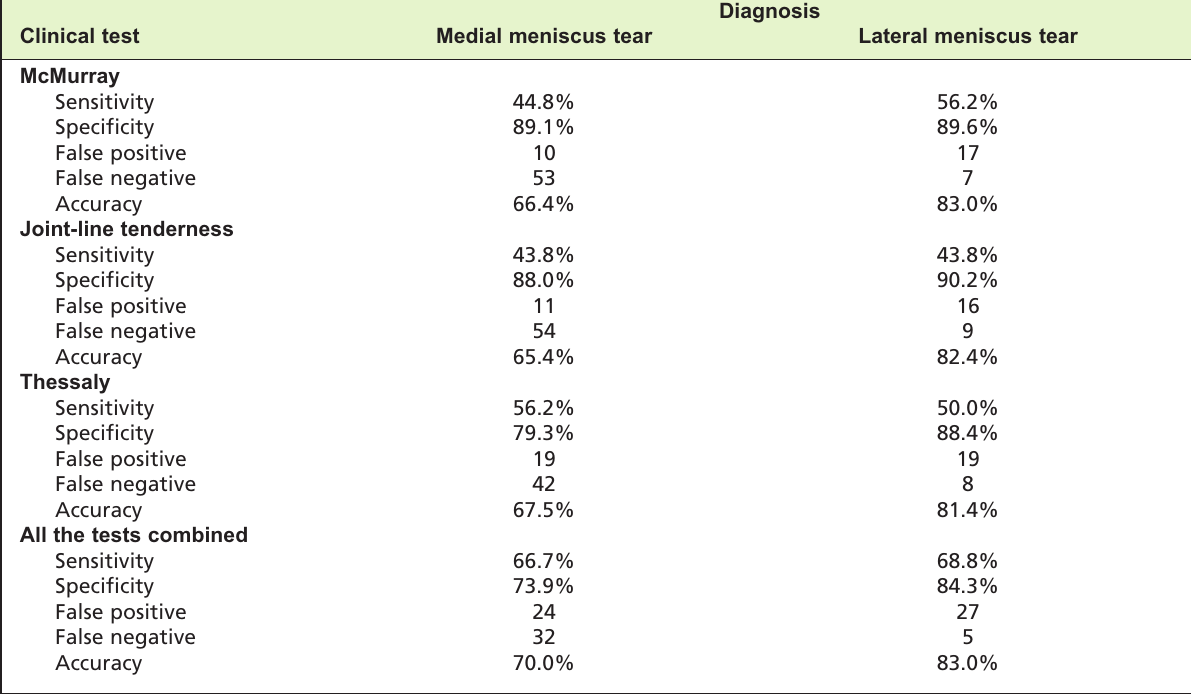
The diagnostic parameters of the three clinical tests with MRI as the standard method of diagnosis (N = 188) Table I: